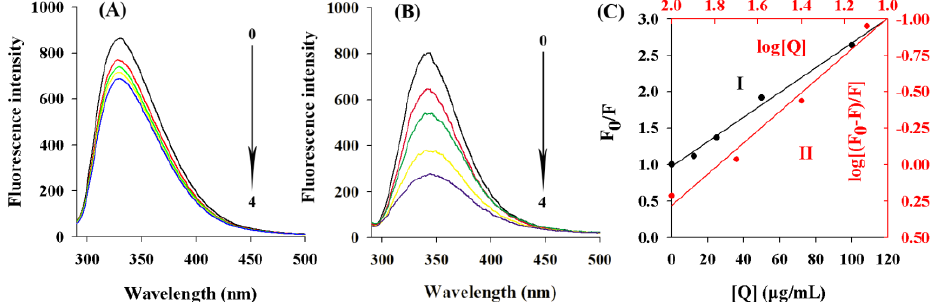
Figure 7. ( A ) Fluorescence spectra of the interaction between copper ion and ASBPs. Curves 0 – 4 represent copper ion concentrations of 0, 24, 48, 72 and 120 µM, respectively; ( B ) Fluorescence spec- tra of tyrosinase at different concentrations of ASBPs. Curves 0 – 4 represent ASBPs concentrations of 0, 12.5, 25, 50 and 100 µg/mL, respectively; ( C ) Plots of Stem-Volmer and log[(F 0 −F)/F] versus log[Q] for the quenching effect of ASBPs against